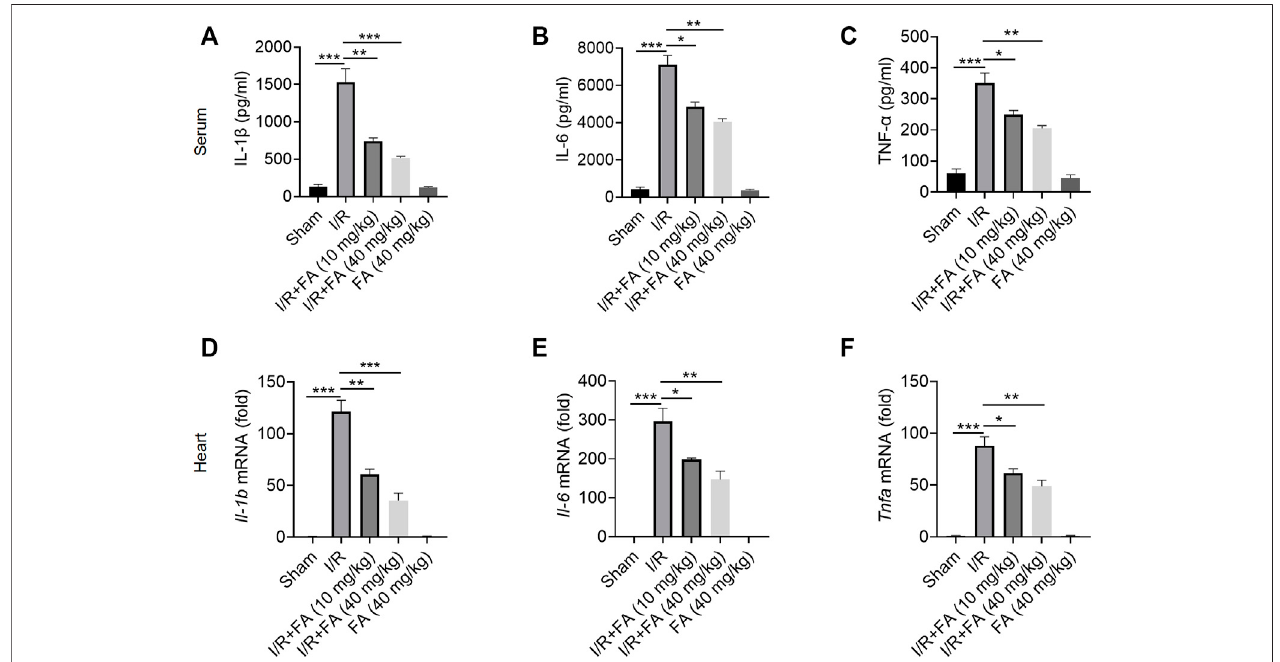
FIGURE2| FAalleviatesthein fl ammatoryresponsetoI/R-inducedmyocardialinjuryinmice. (A – C) Expressionofthein fl ammatoryfactorsIL-1 β ,IL-6,andTNF- α in WTmicewasdetectedbyELISA. (D – F) mRNAexpressionofthein fl ammatorycytokines Il-1b , Il-6 , Il-17 ,and Tnfa inhearttissueofWTmiceineachexperimentalgroup, detected by RT-PCR. Data are expressed as the means ± sd from three independent experiments. * p < 0.05, ** p < 0.01, and *** p <